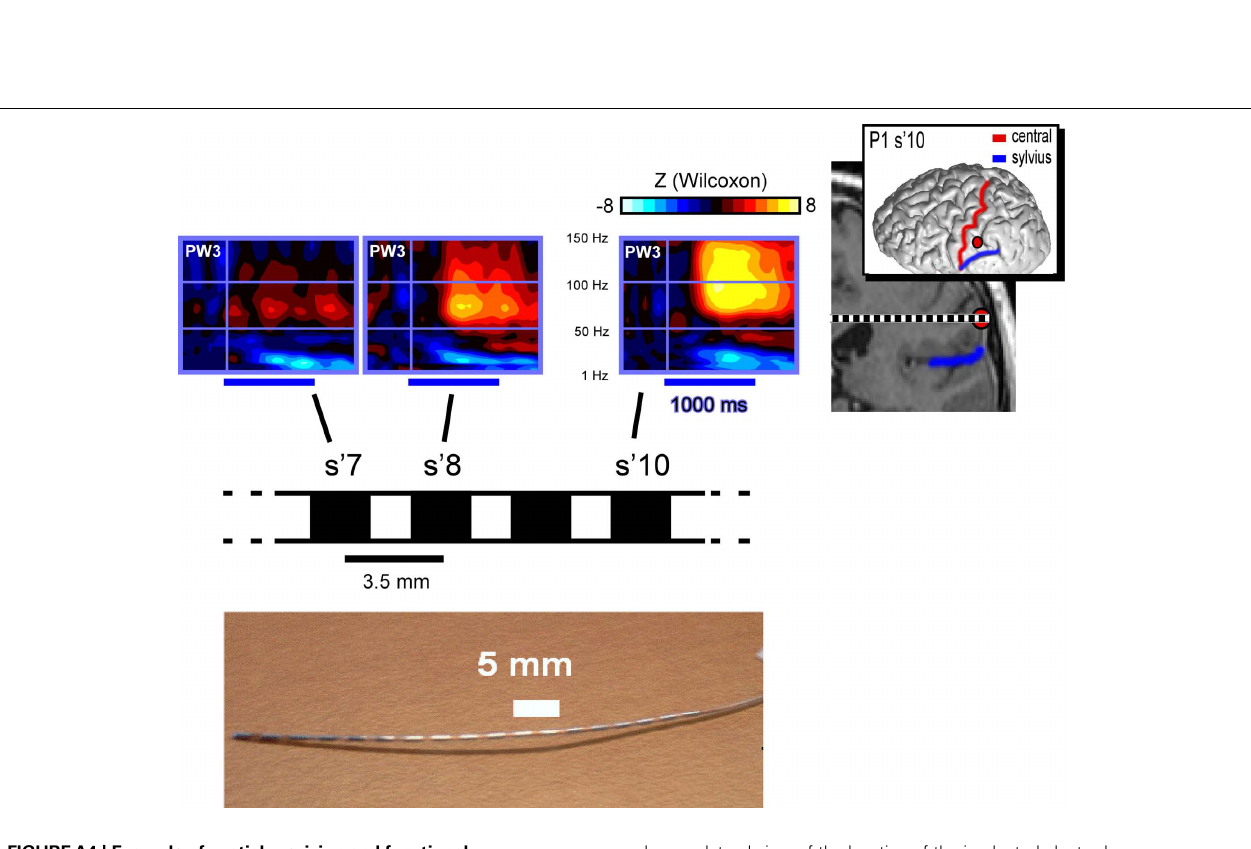
shows a lateral view of the location of the implanted electrode. The patients MRI shows the coronal view and at the same electrode implantation site. Lower panel: a picture of a sample electrode with its recording